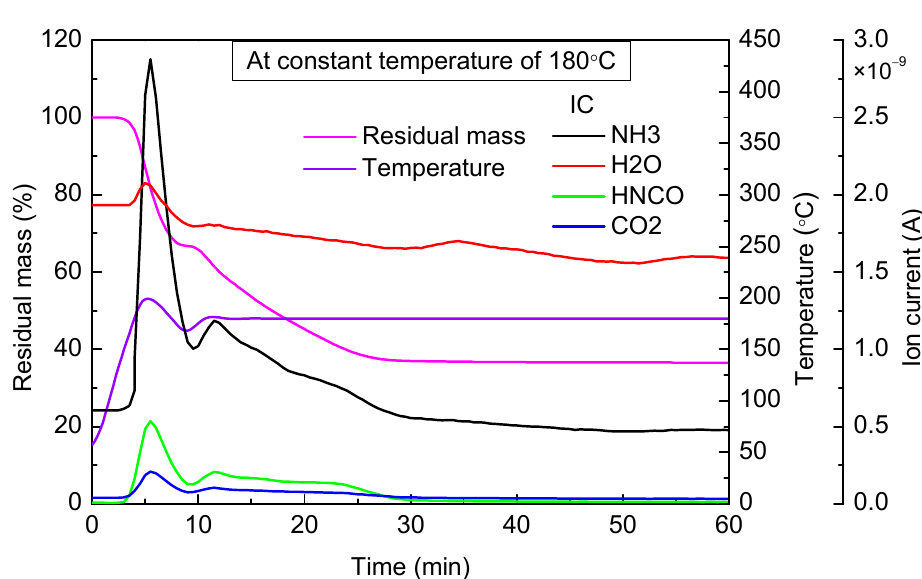
Figure 4. TG-MS results of urea at constant temperature of 180 °C .